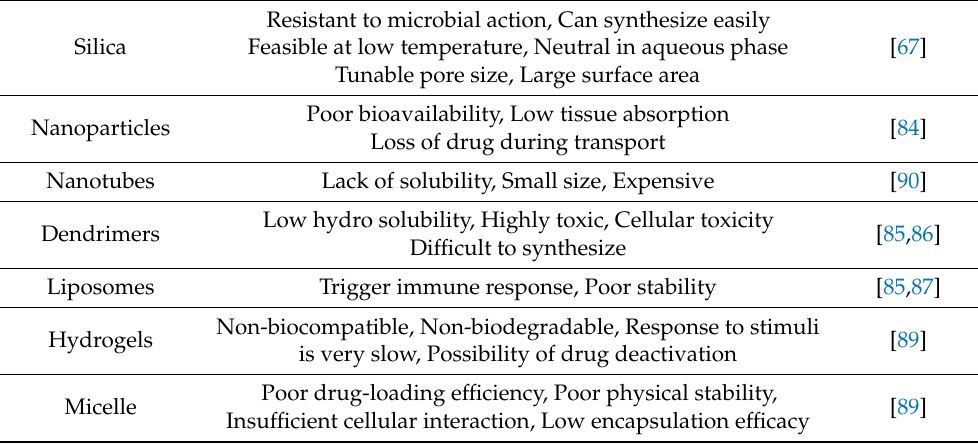
Table 3. A comparison of silica based oral carriers with other oral nanocarriers.